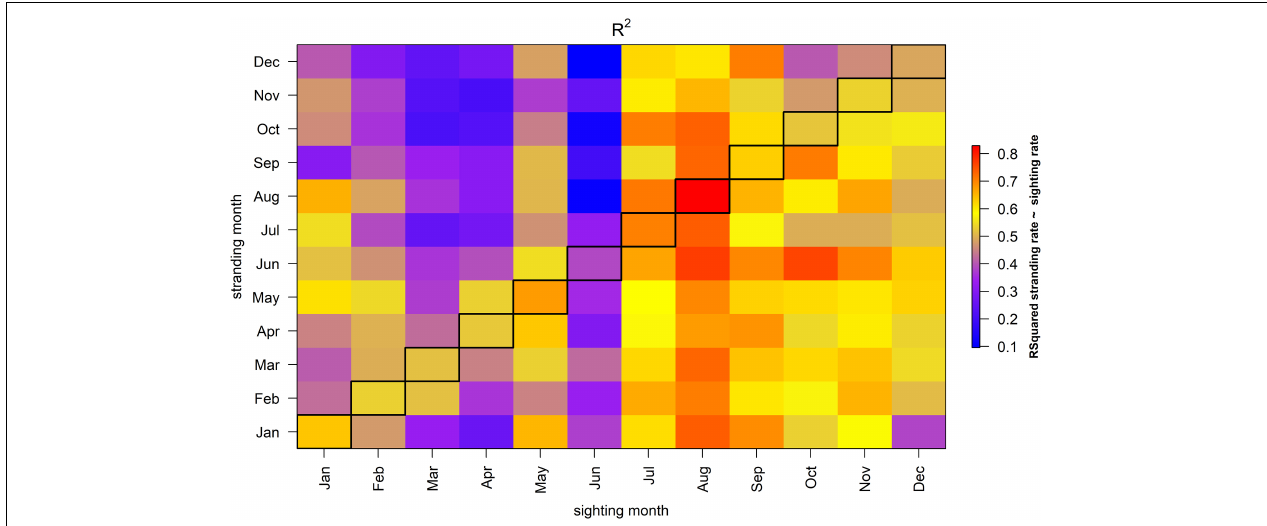
FIGURE 4 | R 2 of model where a stranding in each month is explained by the sighting rate in another month in the same year. The diagonal, bordered column represents coastal sighting rates from the same month and year as a stranding.